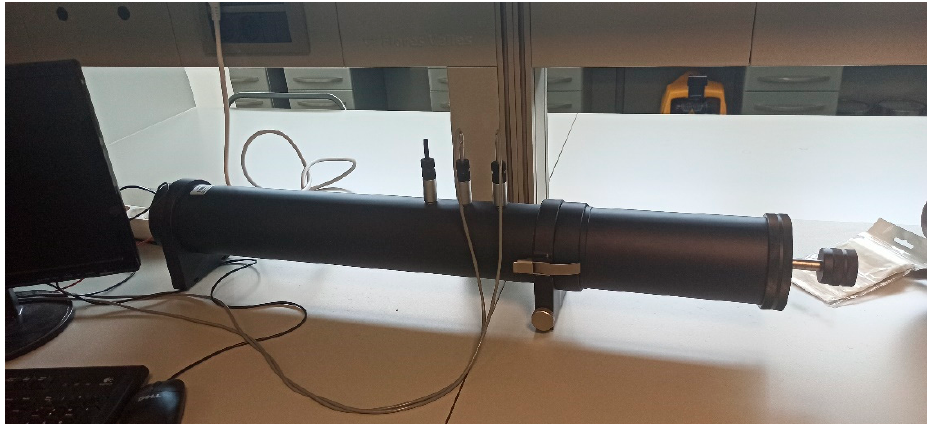
Figure 2. Impedance tube disposition used for the measurements.